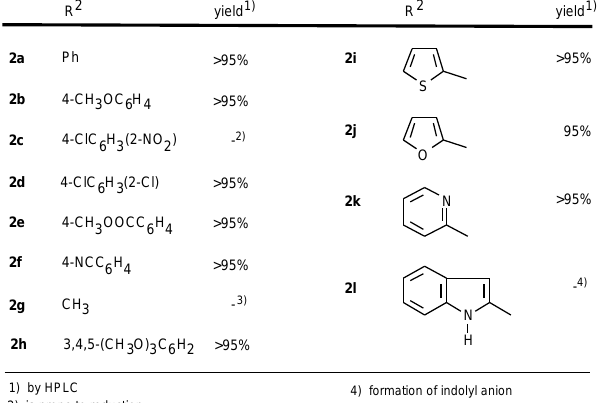
hydrogen sulfate in water/methylene chloride. Substrate